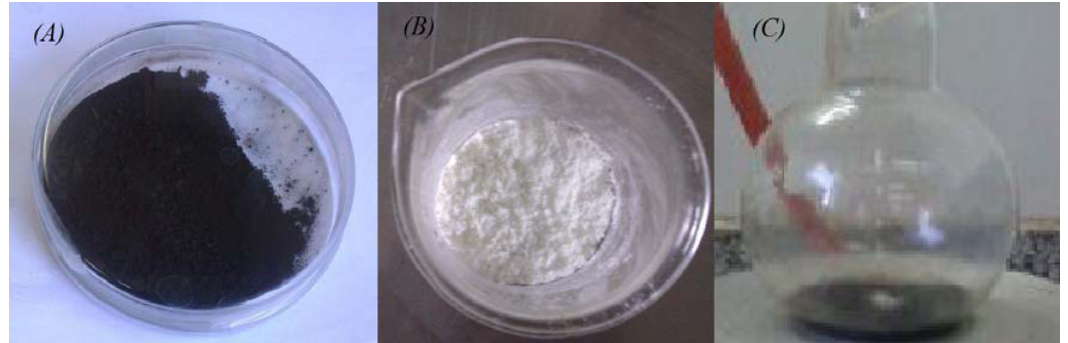
Fig. 1. Novel adsorbent synthesis steps: (A) the magnetic Fe (B) the product of reaction of carbon disulfide and isopropylamine, and (C) the synthesized final adsorbent.